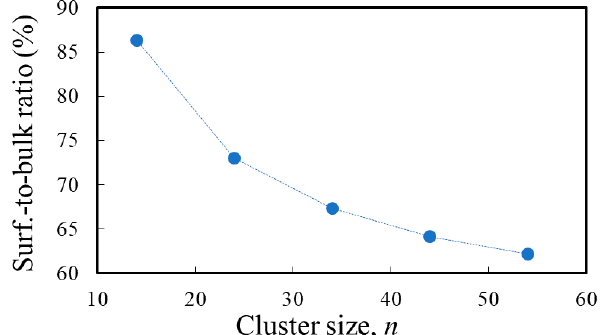
Figure 3. The surface-to-bulk ratio (defined as the fraction of under-coordinated atoms) dependence on the size of Ti n O 2 n +2 H 4 clusters ( n = 14, 24, 34, 44, 54), geometry optimized by DFT/B3LYP/3-21G(d) in vacuum.